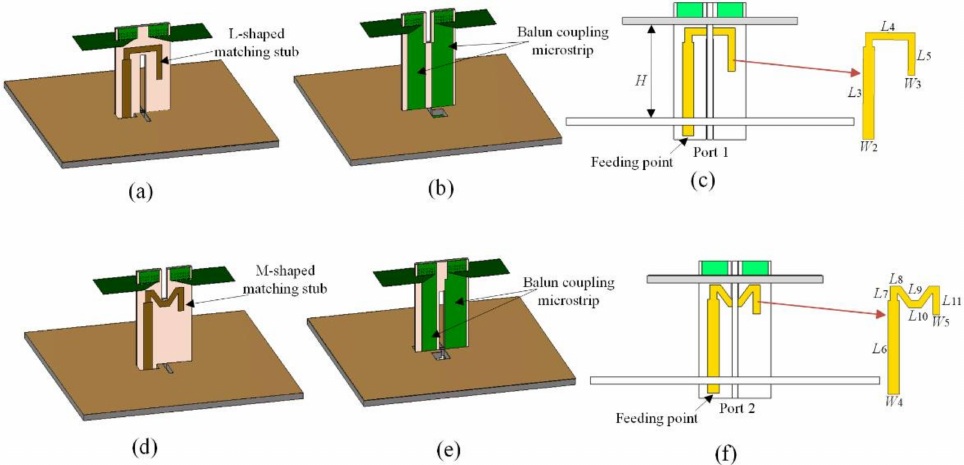
Figure 2. ( a – c ) Structure model of polarized element 1. ( d – f ) Structure model of polarized element